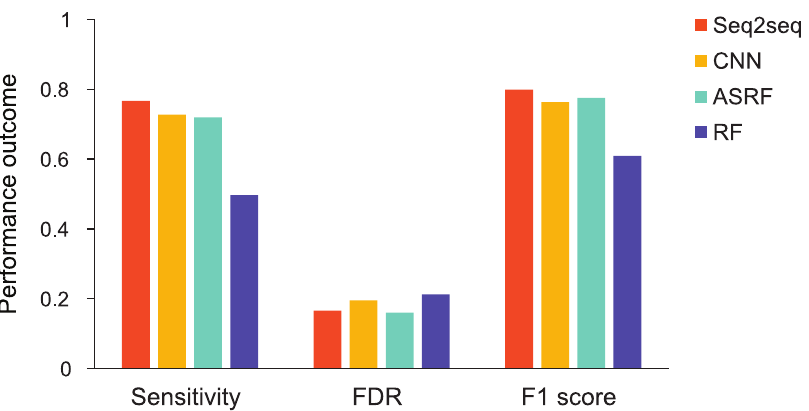
Fig 6. Benchmarking Seq2Seq performance. Prediction outcomes were aggregated from primitives, activities, and patients. Shown are the sensitivity, false discovery rate (FDR), and F1 score for Seq2Seq, convolutional neural network (CNN), action segment refinement framework (ASRF), and random forest (RF). Seq2Seq had the highest sensitivity (Seq2Seq, 0.767; CNN, 0.727; ASRF, 0.720; RF, 0.497). Seq2Seq FDR was lower than CNN and RF but marginally higher than ASRF (Seq2Seq, 0.166; CNN, 0.196; ASRF, 0.160; RF, 0.213). Seq2Seq had the highest F1 score (Seq2Seq, 0.799; CNN, 0.763; ASRF, 0.775; RF,